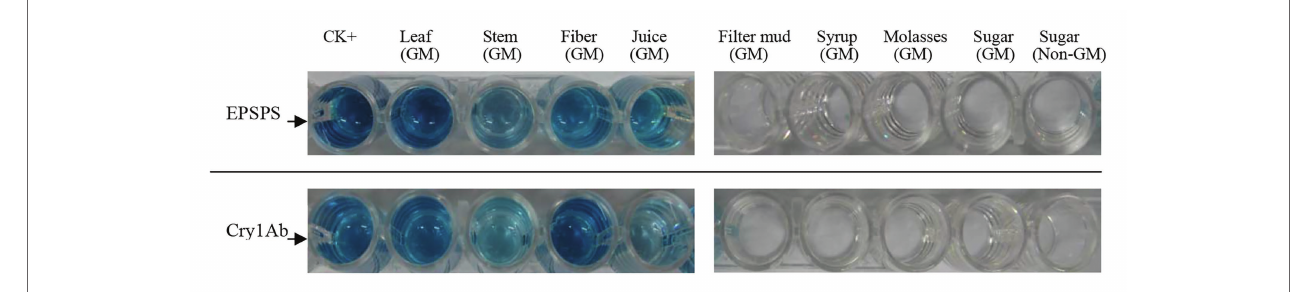
FIGURE 4 | ELISA of all samples.